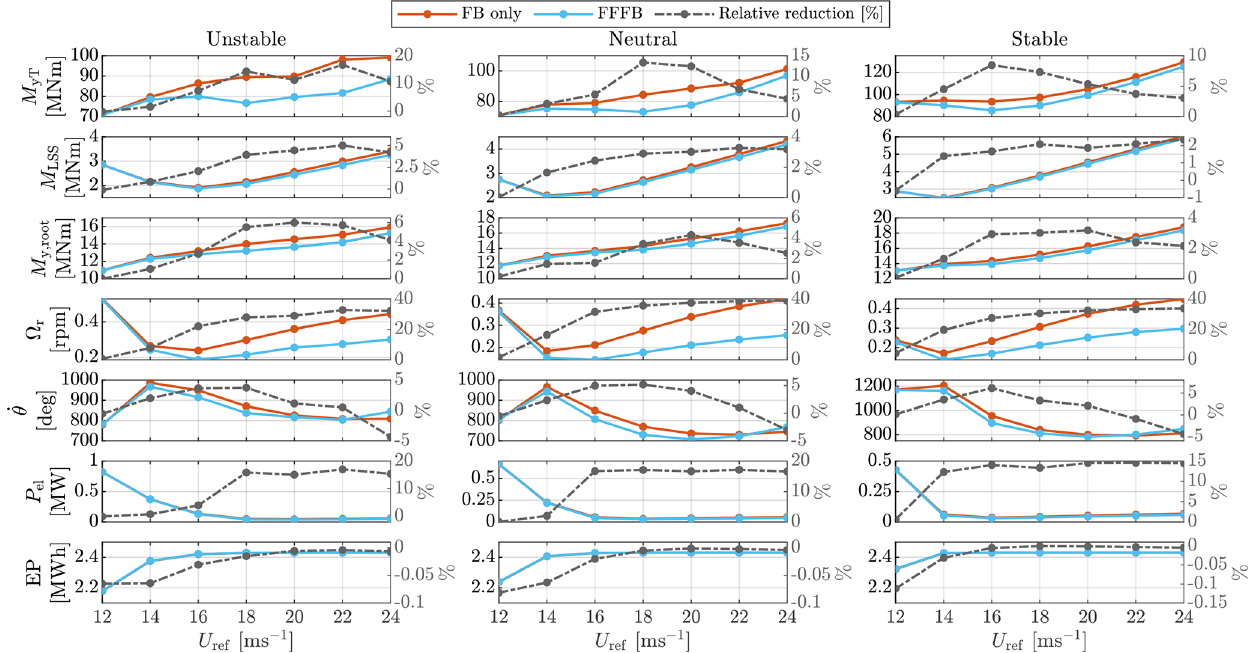
Figure 13. Comparison of DEL ( M yT , M LSS , M y , root ), SD ( (cid:127) r , ˙ θ , P el ), and EP, simulated using the Mann model. Note that the value of the relative reduction are reflected by the right-side y axis. Relative reduction: (FB-only–FFFB)/(FB-only).